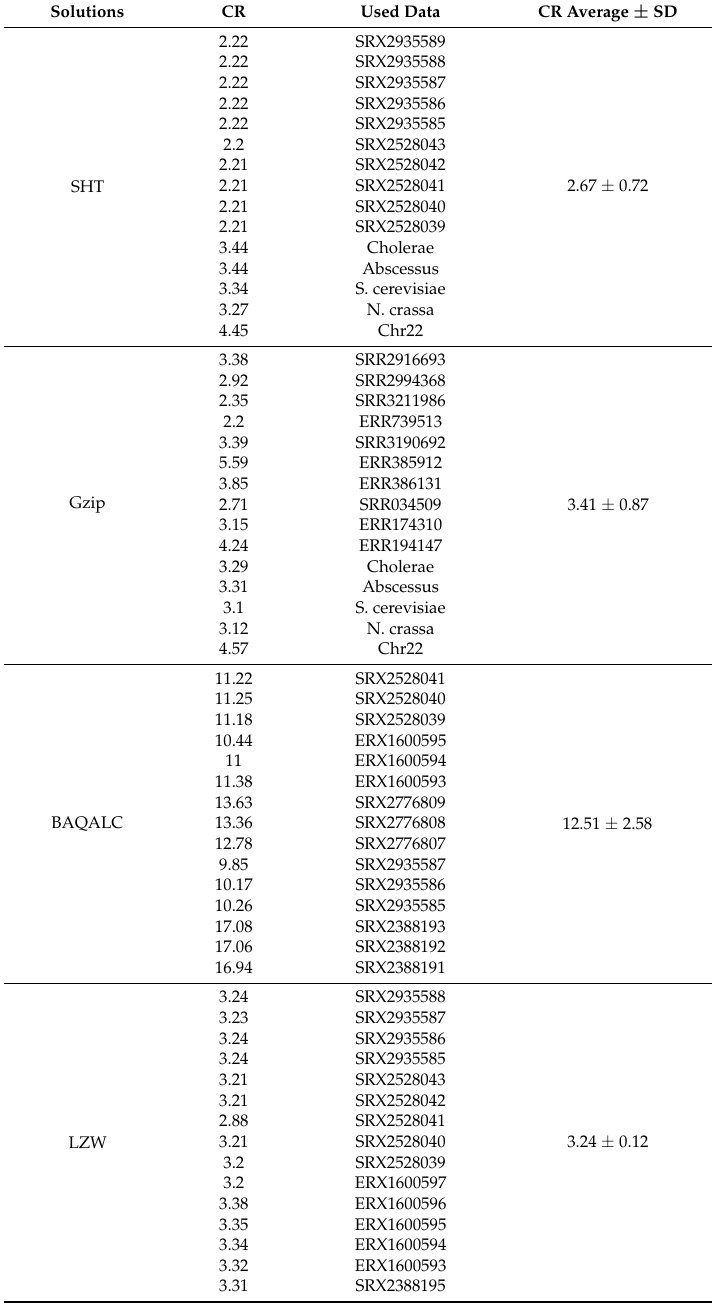
Table 3. CR Comparison between BAQALC and Widely Used Algorithms SHT, LZW, Gzip, and Bzip